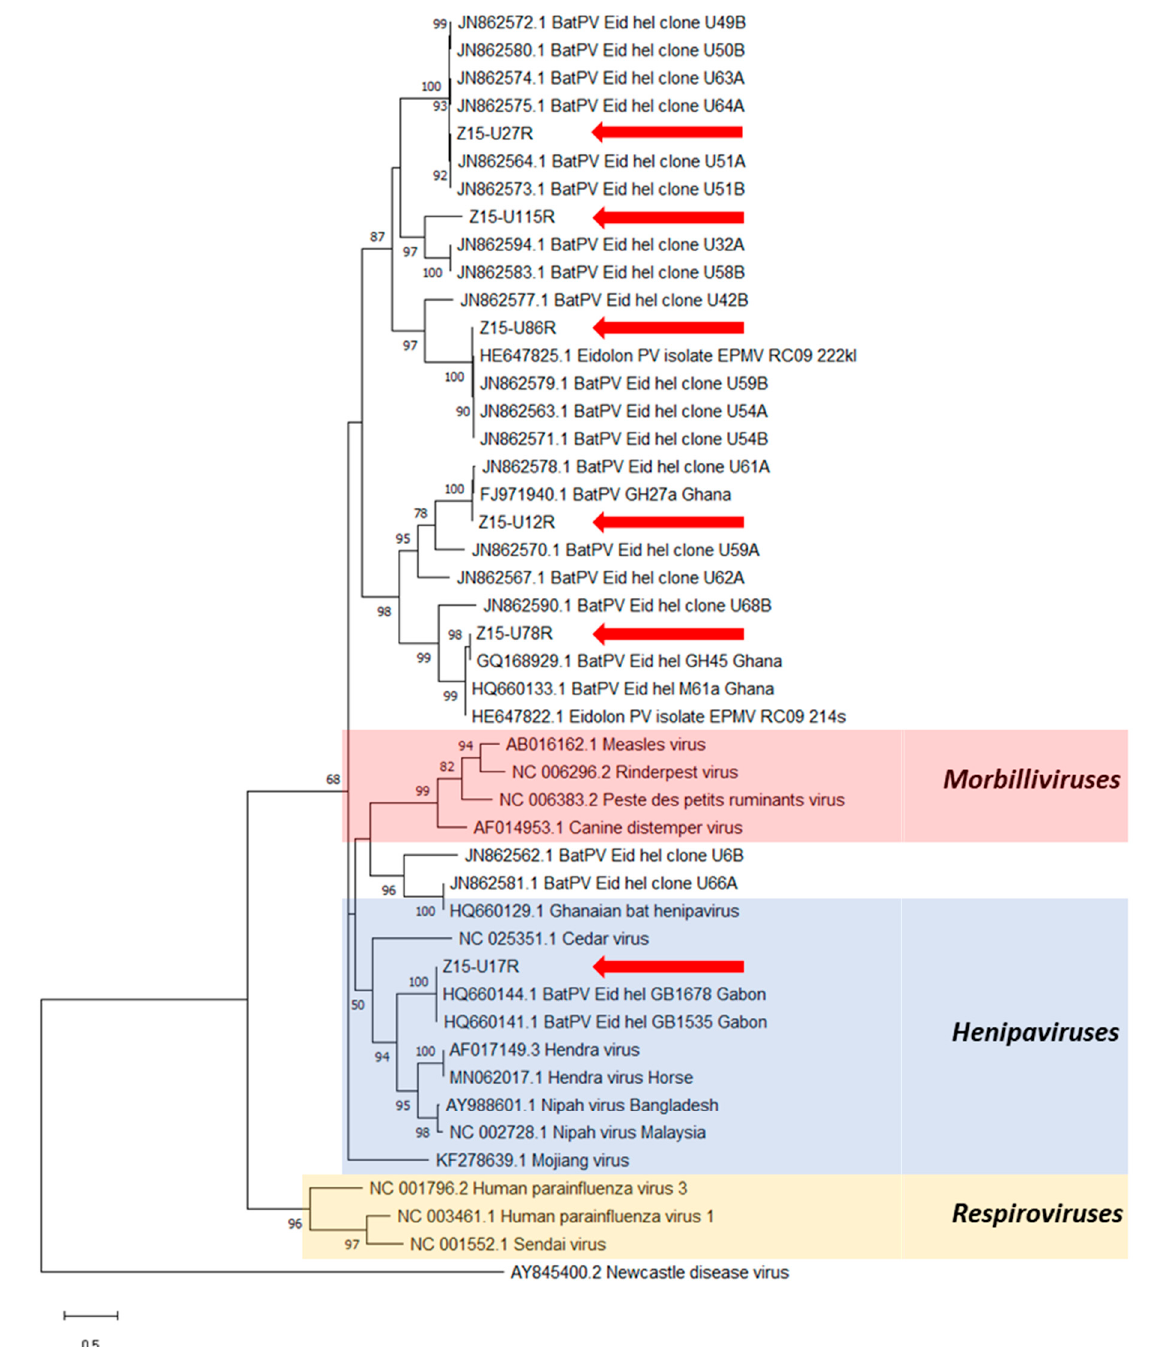
Figure 4. Phylogenetic analysis of partial L gene sequences obtained after RMH-PCR on E. helvum urine samples (red arrows). Maximum likelihood tree with bootstrapping (1000 iterations) generated in MEGA X, using 439 bp alignment against publicly available paramyxovirus sequences (NCBI Genbank) and outgroup Newcastle disease virus. Bootstrap values for 1000 replicates are indicated as percentages (where >50%) and the number of nucleotide substitutions per site is to scale as indicated by the scale bar.